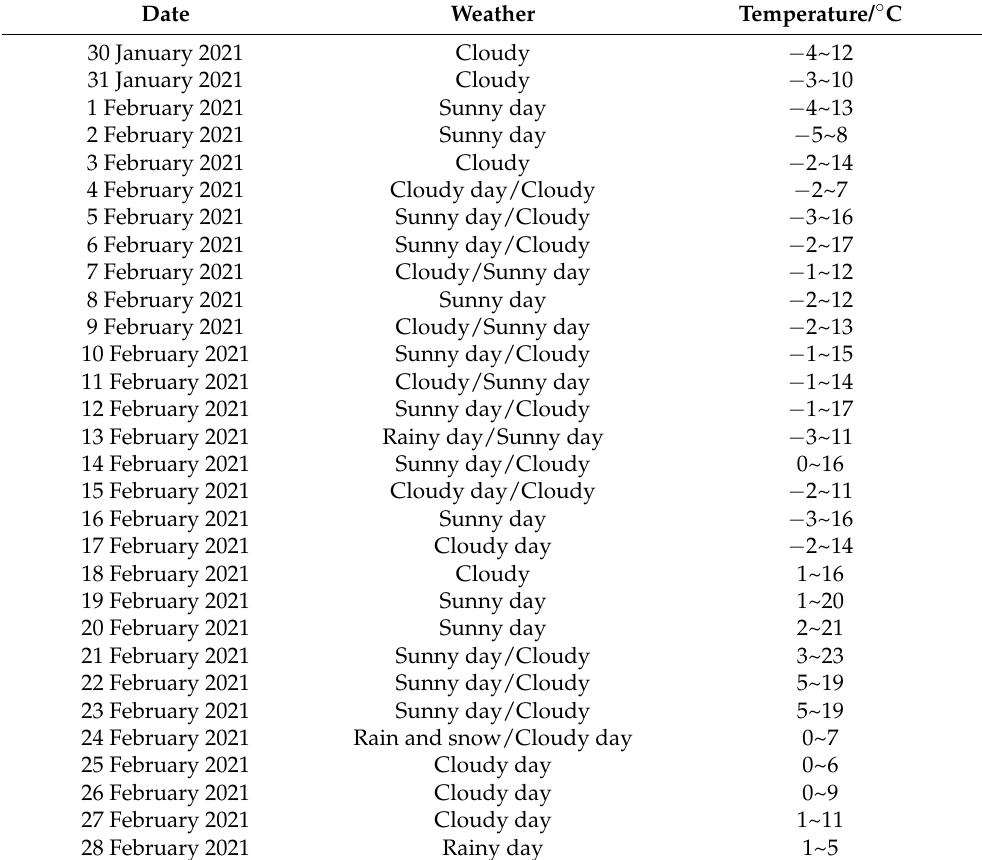
Table 2. Statistics of weather conditions during the test collection period in Xianyang,